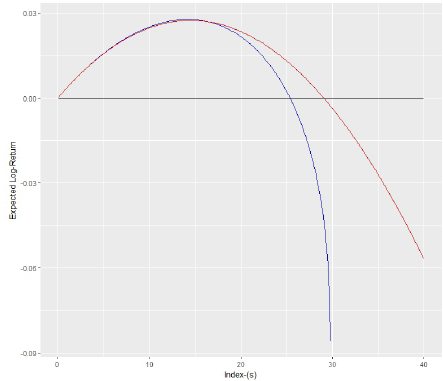
Figure 7. Expected log return vs. approximated curve.